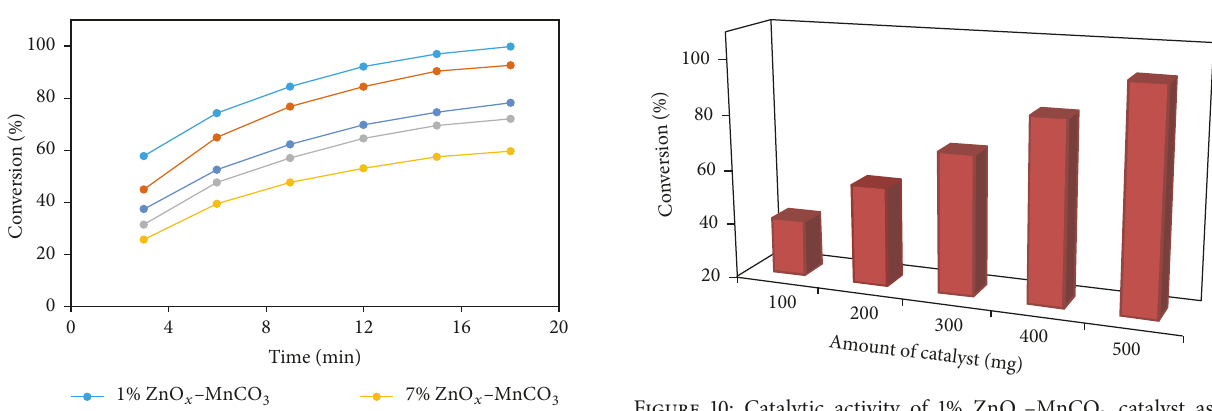
–MnCO 3 catalyst as a x